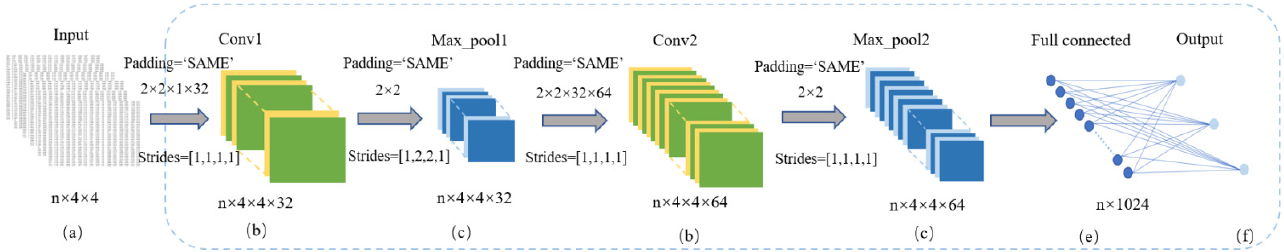
Figure 2. CNN predictor model based on hand motion data.